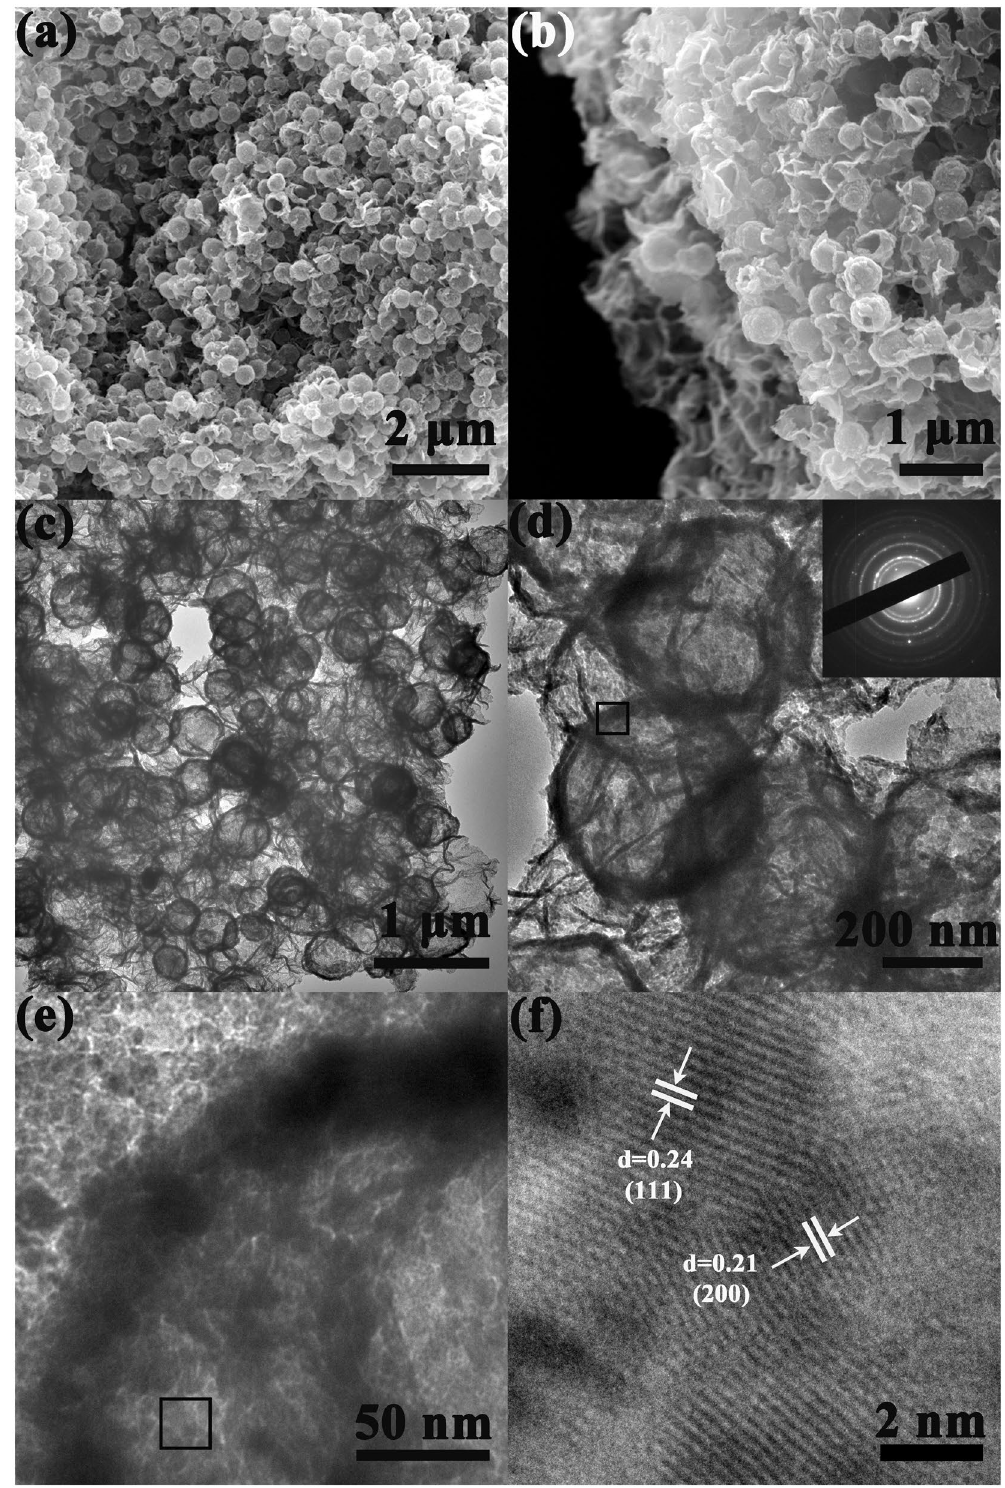
Figure 4. SEM images of 3D NiO hollow sphere/rGO composite ( a , b ); TEM images ( c , d , e ) of NiO hollow sphere/rGO composite, and the inset in ( d ) is the corresponding SAED pattern; (( f ) HRTEM image of NiO hollow